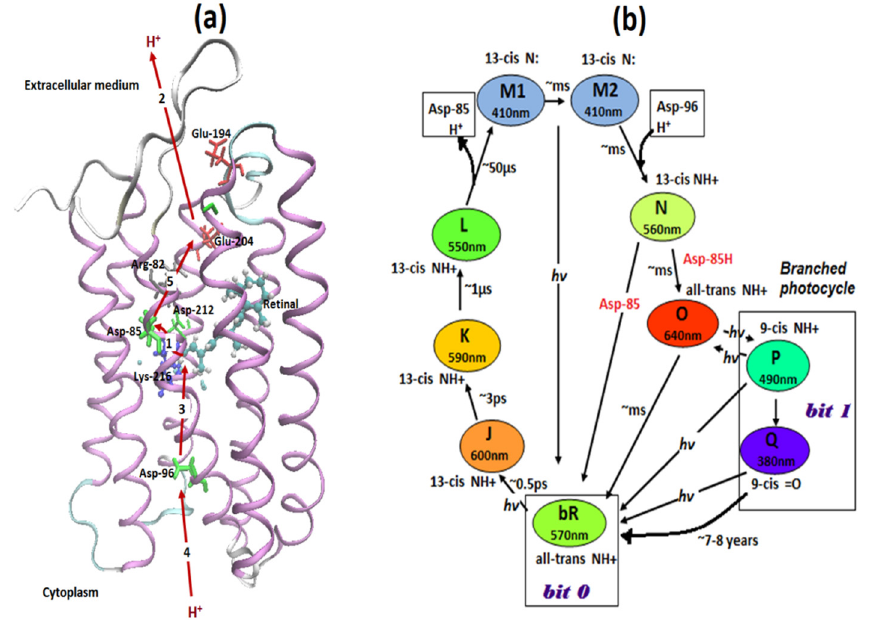
Figure 1. Proton transfer mechanism and binary logic in bR: ( a ) Location of key residues within bR and around the retinal showing the proton path from cytoplasm to extracellular environment; ( b ) Photochemical states of bR highlighting the ‘Branched photocycle’ that is responsible for binary state ‘1 ′ (9- cis ) for the molecule. Binary state ‘0 ′ (all- trans ) is also highlighted as the ground state.